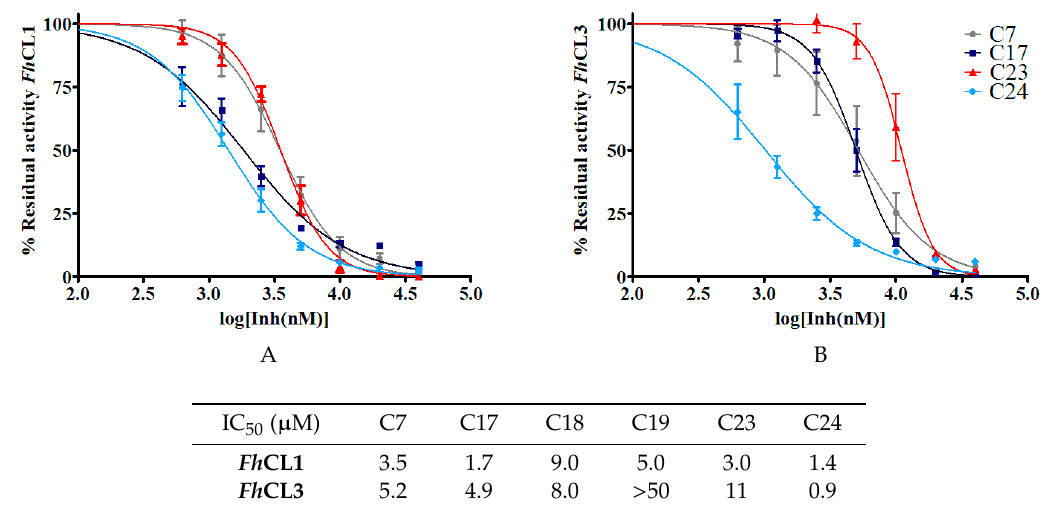
Figure 4. The IC 50 of the hit quinoxaline 1,4-di- N -oxide derivatives are shown in µM. To obtain the IC 50 value, the percentage of residual enzymatic activity for (A) Fh CL1 and (B) Fh CL3 was plotted against the logarithm of the concentration of compound (log[Inh(nM)]). The dose-response curves for the best inhibitors C7 , C17 , C23, and C24 are shown below.